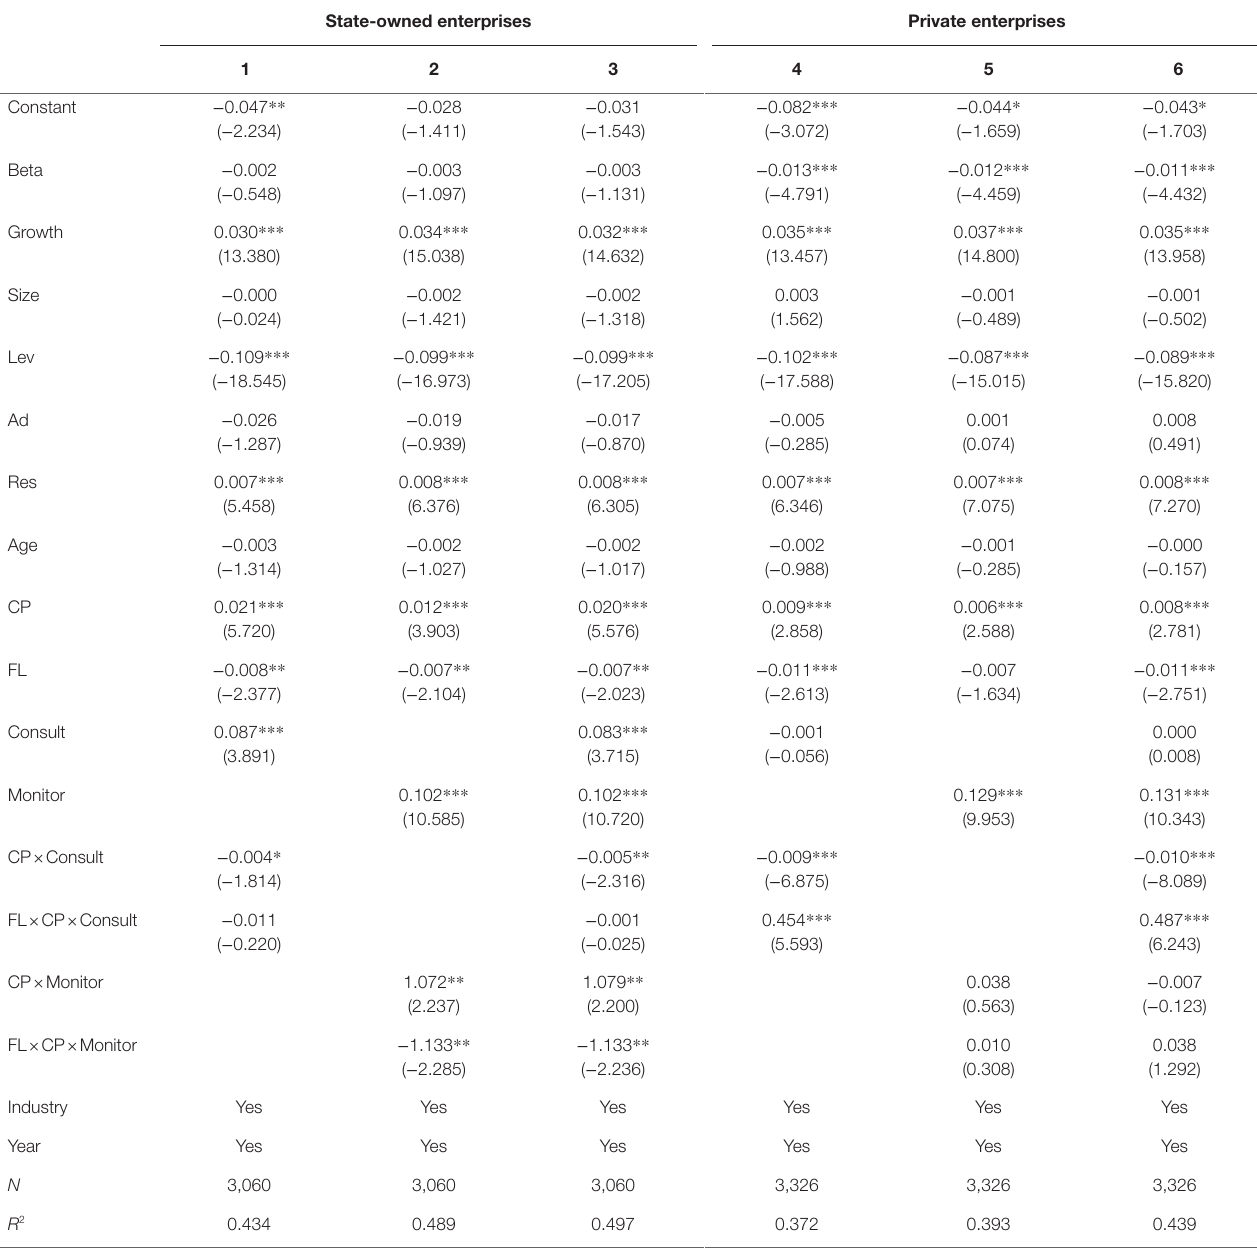
TABLE 6 | Regression results of the moderating impact of board fault